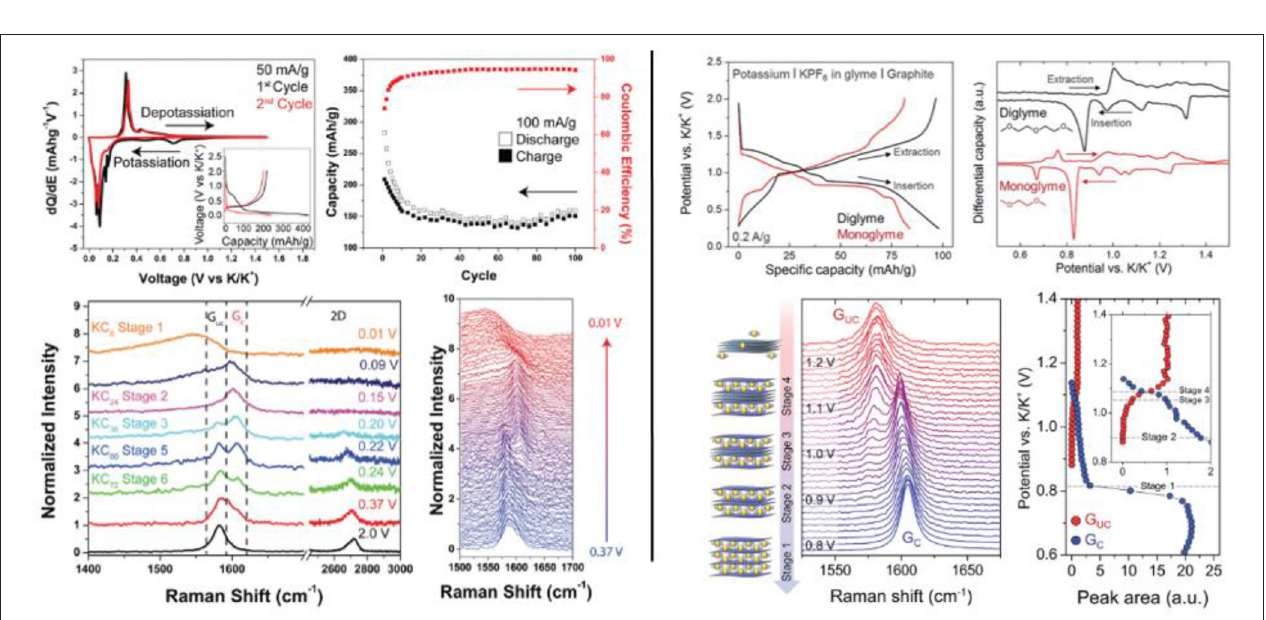
FIGURE 2 | Left-top, electrochemical behavior and performance of few layer graphene electrode with carbonate based electrolyte. Left-bottom, in situ evolution of the Raman spectra during LSV at 0.5 mV/s. Right-top, electrochemical behavior of natural graphite with ether based electrolyte. Right-bottom, in situ evolution of the Raman spectra during LSV measurement. Reproduced from Cohn et al. (2016) and Share et al. (2016a) with permission from the Royal Society of Chemistry.